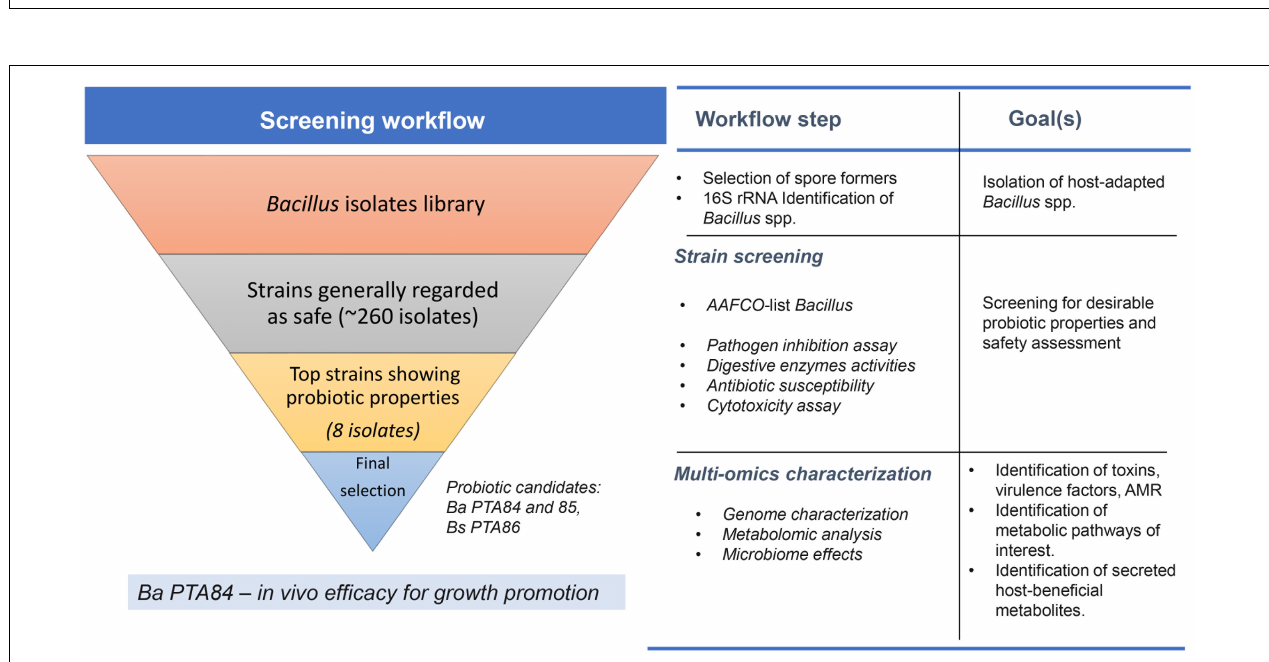
FIGURE 8 | A screening workflow diagram for selection of Bacillus spp. probiotic candidate. Bacillus spp. isolates were screened for their activities to inhibit poultry pathogens and ability to secrete digestive enzymes in vitro . The best candidates were further selected based on their safety profiles (i.e., antimicrobial resistance profile and cytotoxicity level). Genomic and metabolomic analyses were performed on the select isolates to further investigate potential host-benefit properties and possible health/safety concerns. The top candidate was then tested for its effects on growth promotion in vivo .